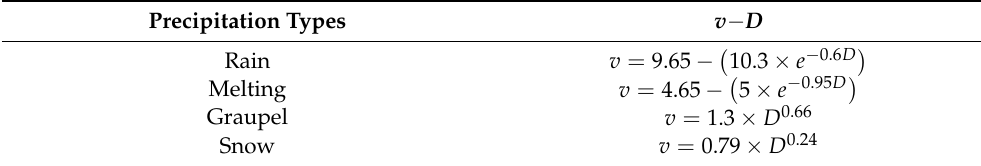
Table 6. The relationship of v − D for rain, melting, graupel and snow. Precipitation